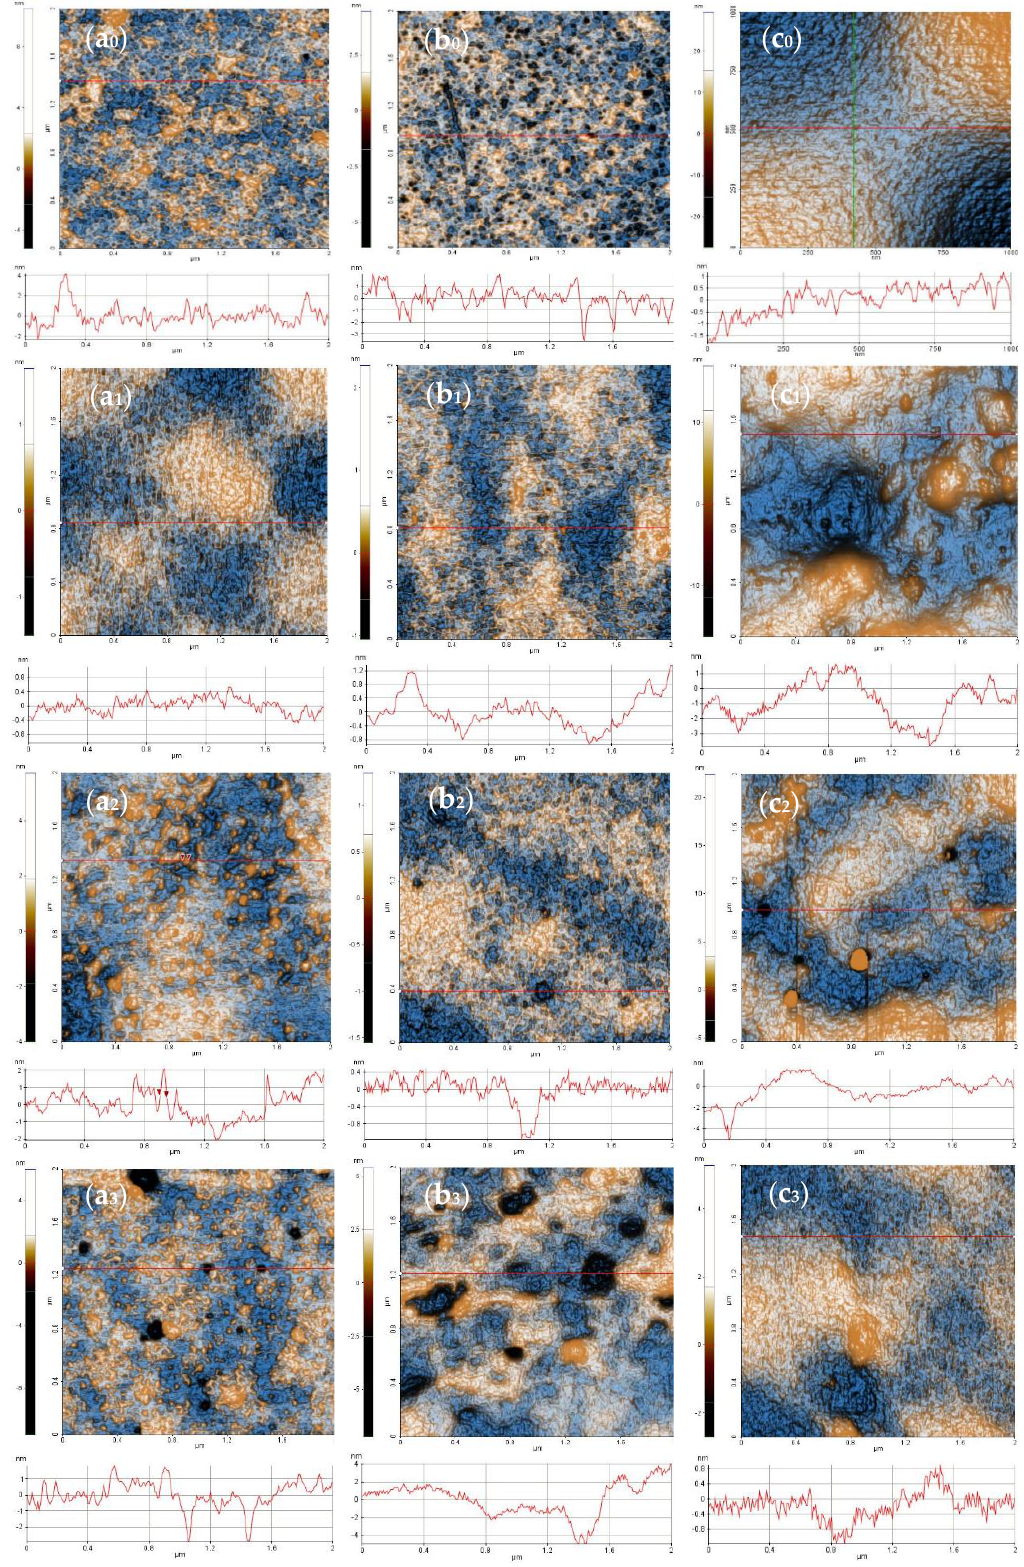
Figure 7. Two-dimensional topographic atomic force microscopy (AFM) images of multilayer films of ( a ) (PAC 18 Na/PDADMAC) 20 , ( b ) (PAC 18 Na-C 14 TAB/PDADMAC) 20 , and ( c ) (PAC 18 Na-C 18 TAB/ PDADMAC) 20 exposed to E. coli ATCC 25922 (subscript 1), S. aureus ATCC 25923 (subscript 2), P. aeruginosa (subscript 3), and without bacteria (subscript 0). Characteristic surface profiles (line scans) are shown near each AFM image. The subscript 20 indicates the number of bilayers.